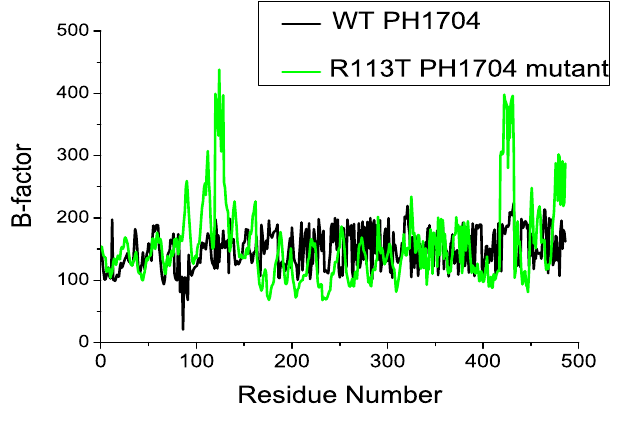
Figure 6. Backbone residue-based B-factors calculated over the 15 ns time window for PH1704 (black), and R113T mutant